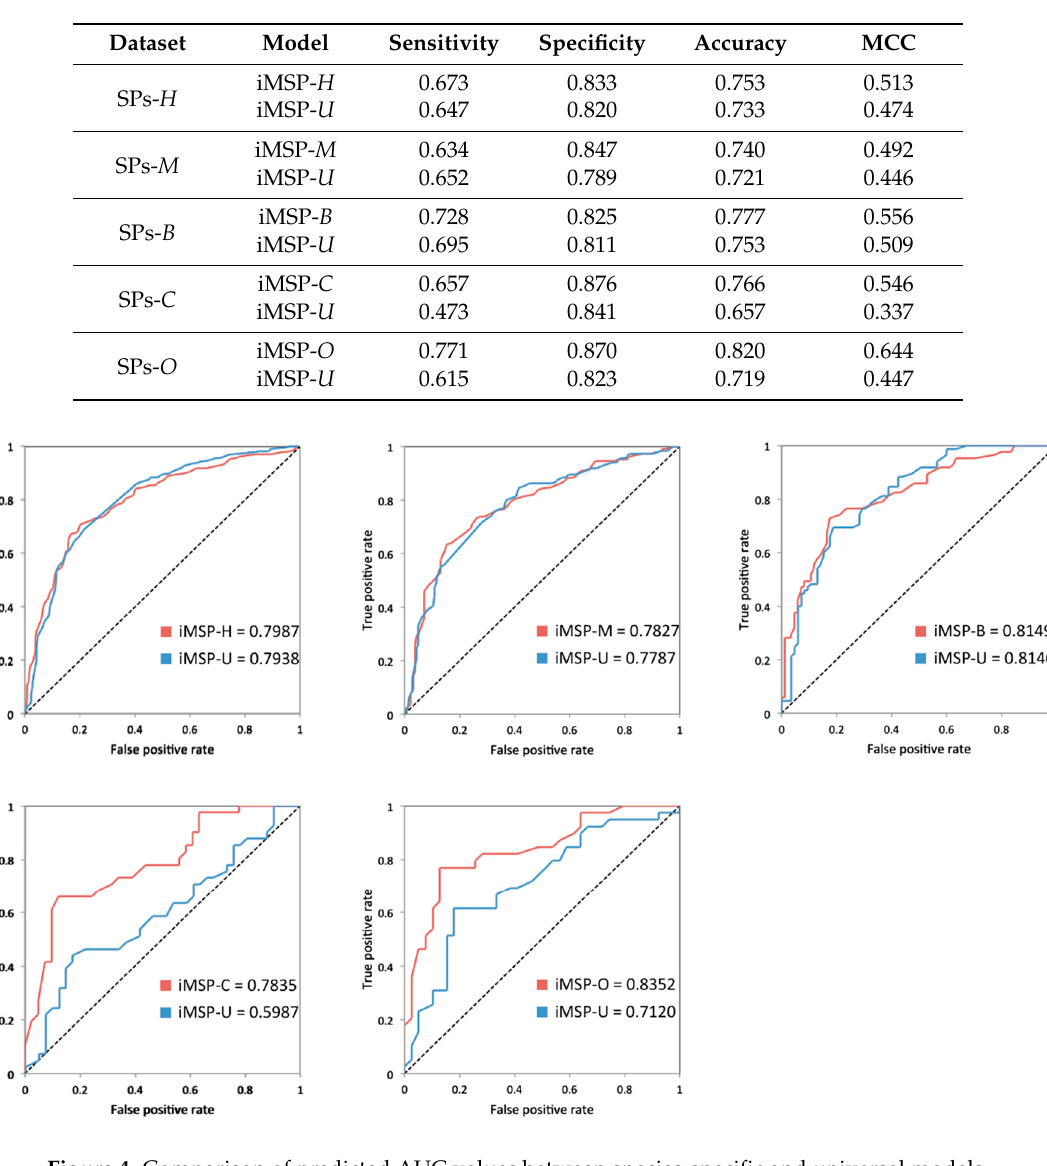
Figure 4. Comparison of predicted AUC values between species-specific and universal models.